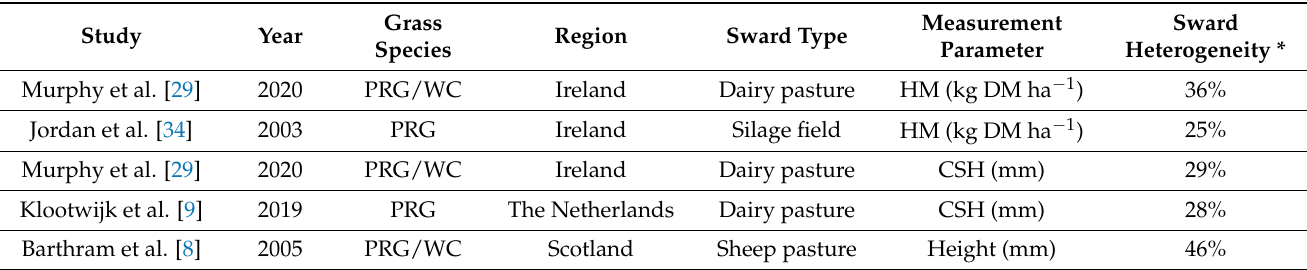
Table 1. Summary of reported values of mean sward heterogeneity in terms of pre-grazing grass quantity on temper- ate